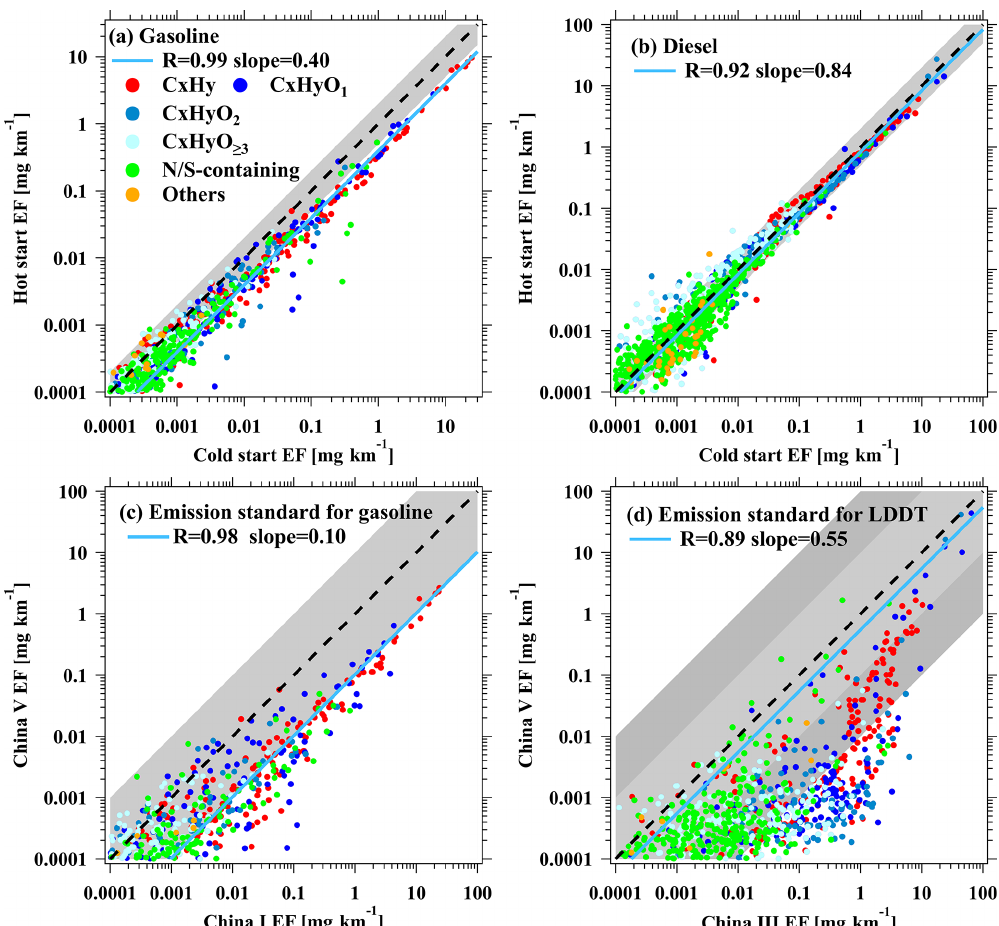
Figure 7. Scatterplots of VOC emission factors between cold starts and hot starts for gasoline (a) and diesel vehicles (b) . Scatterplots of VOC emission factors between China I and China V emission standards for gasoline vehicles (c) and between China III and China V emission standards for diesel vehicles (d) . Each data point indicates a VOC species measured by the PTR-ToF-MS. The blue lines are the fitted results for all data points. The dashed black lines represent 1/1 ratio, and the shaded areas represent ratios of a factor of 2 in (a) and (b) , as well as a factor of 10 and 100 in (c) and (d)